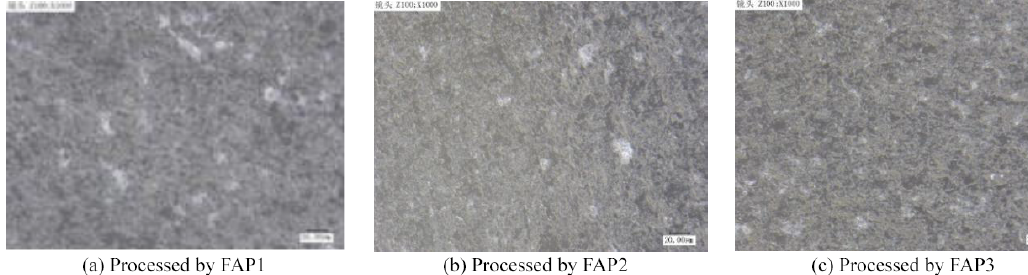
Figure 11. Morphology of sapphire processed by different FAPs.